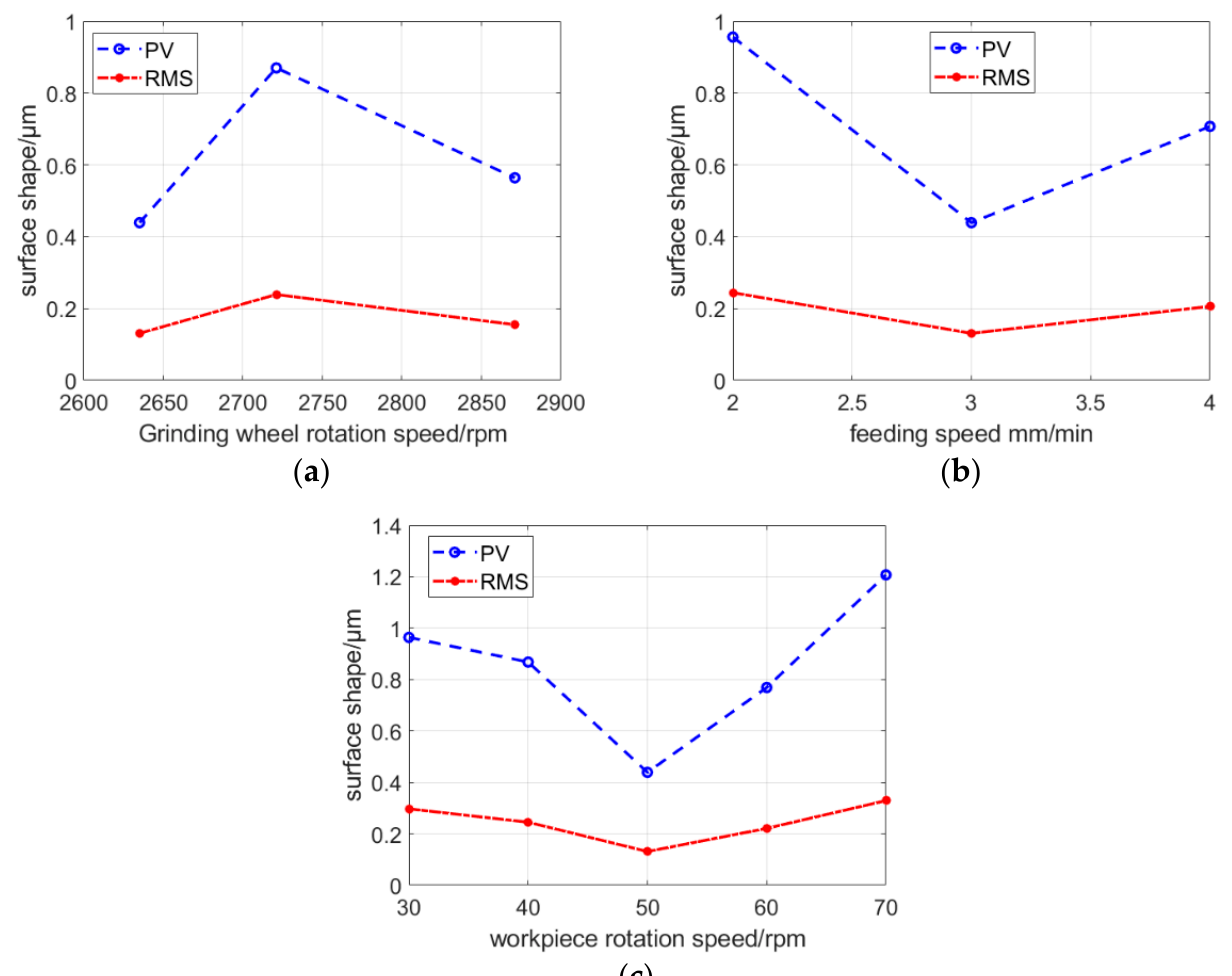
Figure 8. Influence of different parameters on face shape. ( a ) Relationship between surface shape accuracy and grinding wheel speed. ( b ) Relationship between surface shape accuracy and feed speed. ( c ) Relationship between surface shape accuracy and workpiece speed.